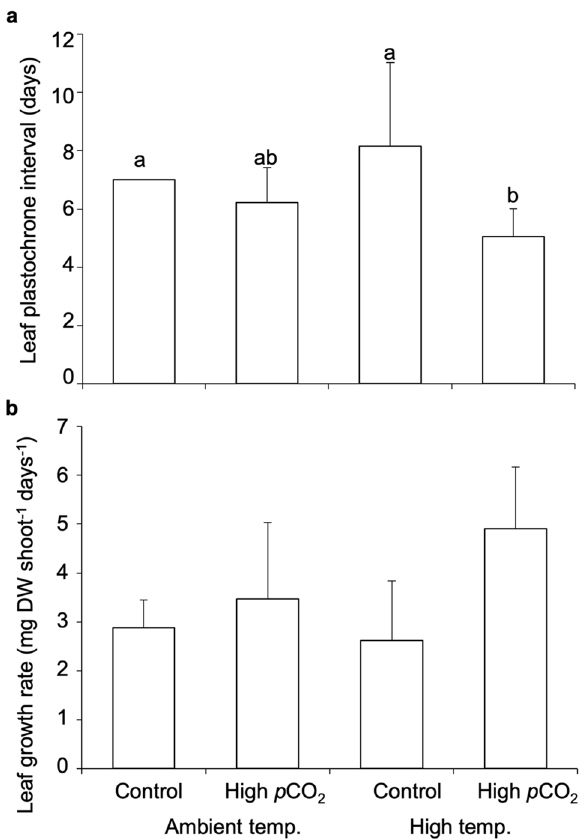
Figure 1. Effect of high temperature (+ 3 °C than ambient) and high p CO 2 (1000 µatm) on the plasctochrone interval and growth rate of seagrass Thalassia hemprichii . ( a ) leaf plastochrone interval (P L ); and ( b ) leaf growth rate. Values represent mean ± SD. n = 6. Different letters indicate statistically significant differences among treatment (Tukey’s HSD post-hoc